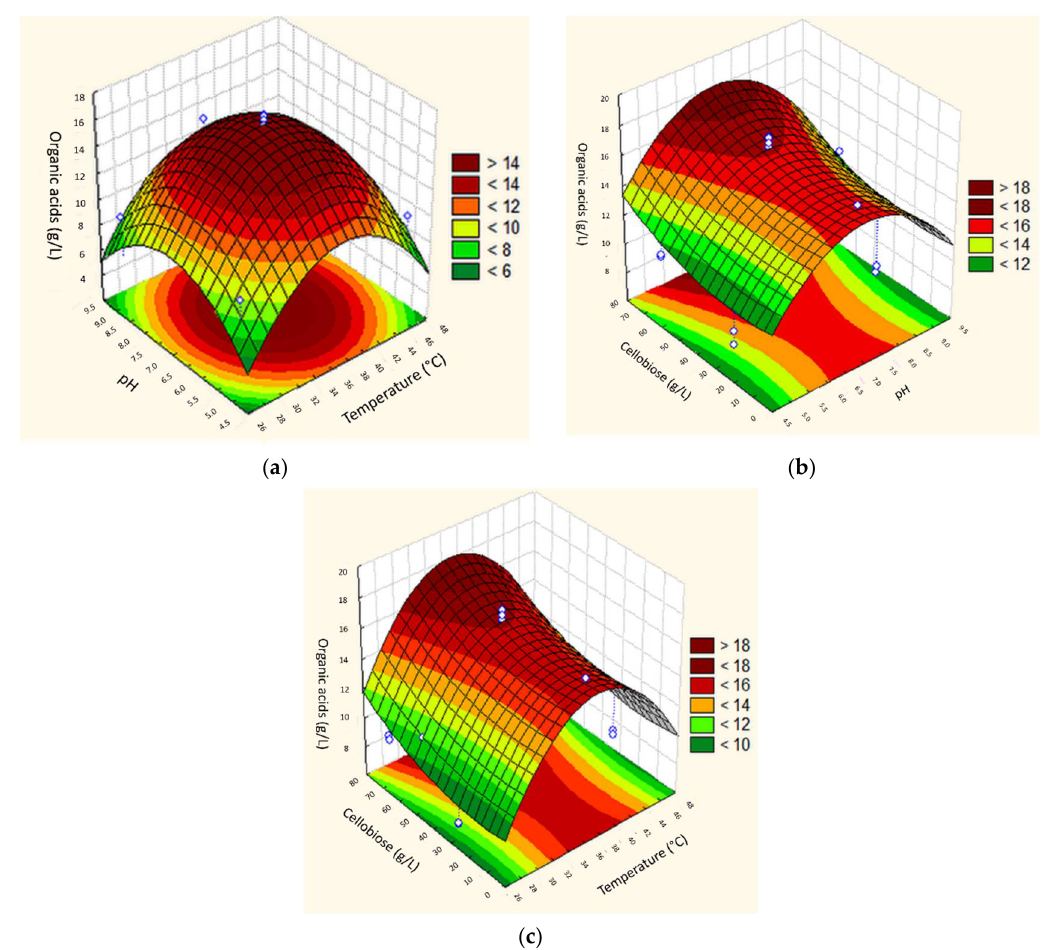
Figure 5. Response surface plot and corresponding contour plot for organic acids production by mixed anaerobic culture, showing ( a ) the effect on the response of the initial broth pH and fermentation temperature, ( b ) the effect on the response of the cellobiose concentration and the initial pH of the broth and ( c ) the effect on the response of the cellobiose concentration of the broth and the fermentation temperature.